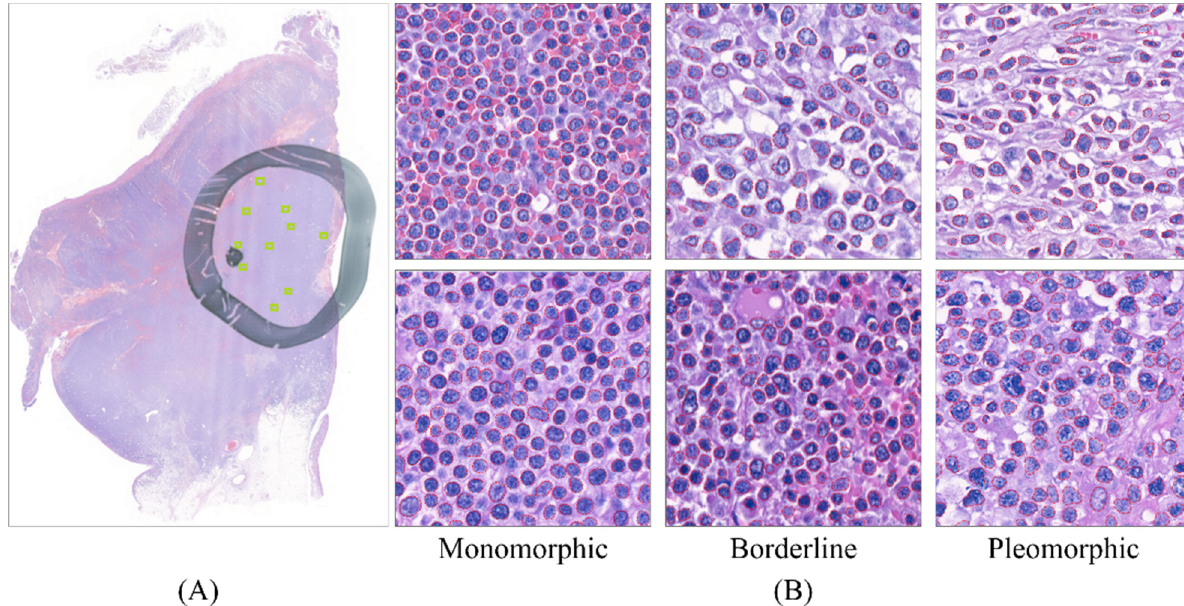
Figure 1. Sample images used as the dataset. ( A ) An example of the whole-slide image. A high-quality region was manually marked by a senior hematopathologist using a black circle. The tiny green boxes represent the randomly sampled high-power fields (HPF). ( B ) Representative HPF images of the neoplastic lymphocytes from MEITL (left), borderline (middle), and ITCL-NOS (right) cases. The neoplastic lymphocytes detected and segmented by the model are contoured in red line. Table 2. Dataset used at each phase of machine learning